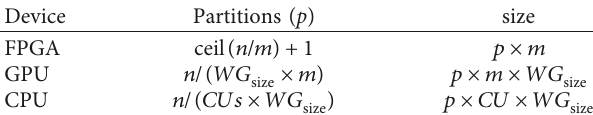
Table 3: oclspkt kernel partitioning schemes. Device